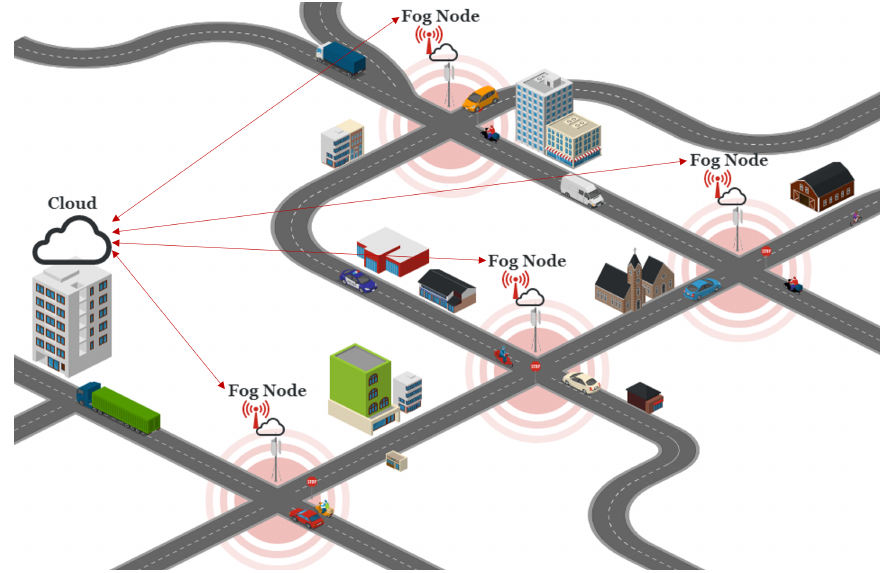
Figure 2. Systems architecture: the Prediction of collisions related to the VRU use case. In this architecture, each end device (vehicle) connects with a Fog Node, which is located at a road intersection, using wireless access technologies (e.g., IEEE 802.11p). The Fog Nodes can be connected to the Cloud using the IP core